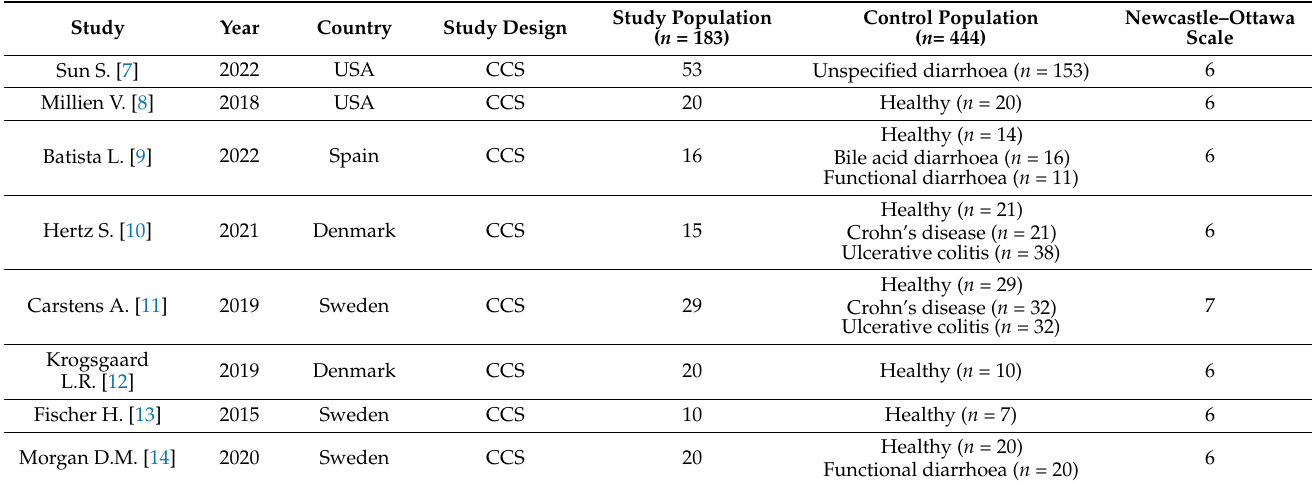
Table 1. Description of the included studies concerning microscopic